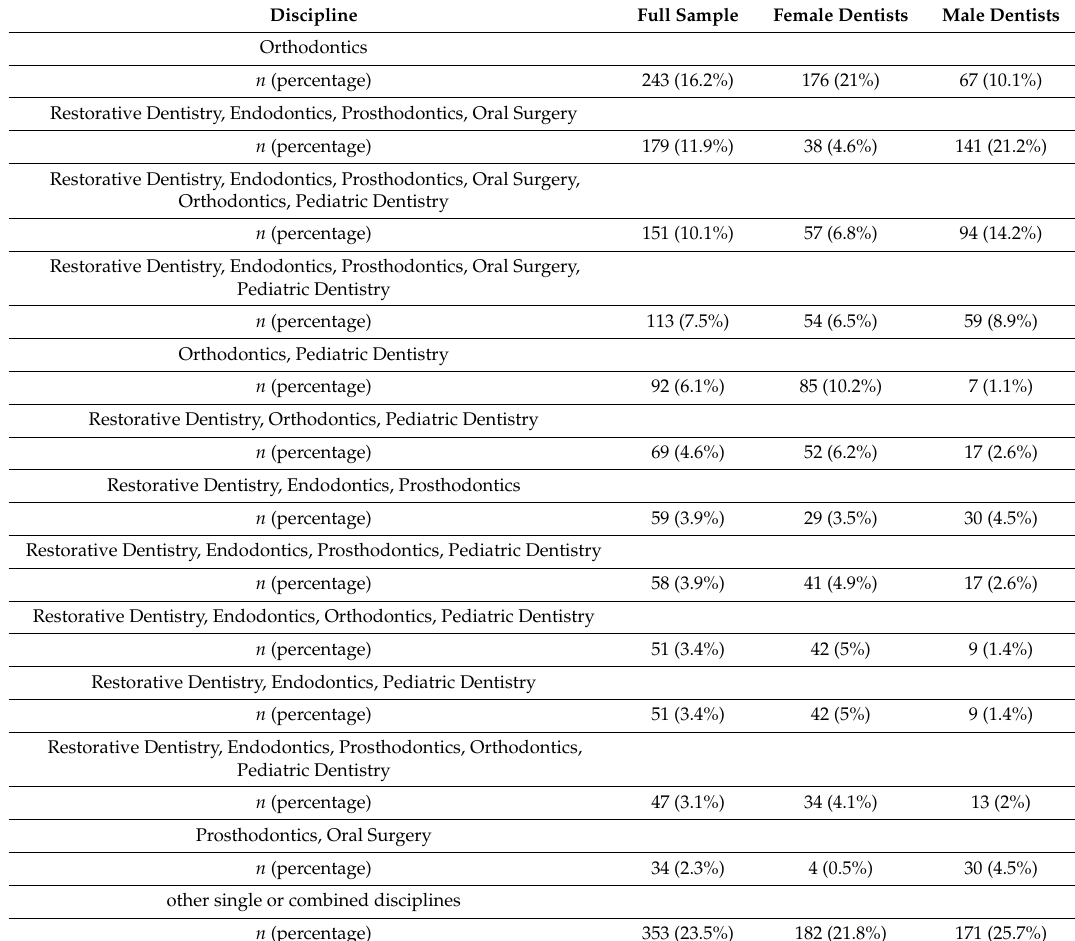
Table 2. Discipline distribution practiced from respondents in the full sample and in the groups of female and male